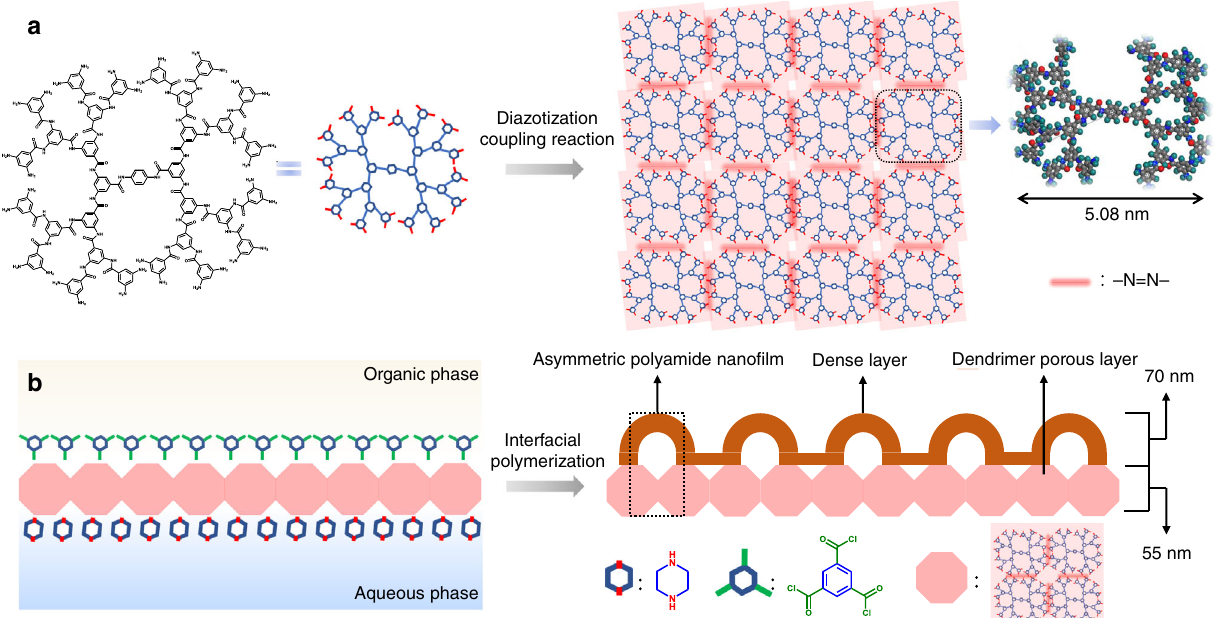
Fig. 1 Formation of dendrimer porous layer and asymmetric polyamide nano fi lm. a Structure of the 32-amines terminated polyamide dendrimer, and the as-prepared dendrimer porous layer assembled by diazotization-coupling reaction. b Schematic of asymmetric polyamide nano fi lm prepared on the dendrimer porous